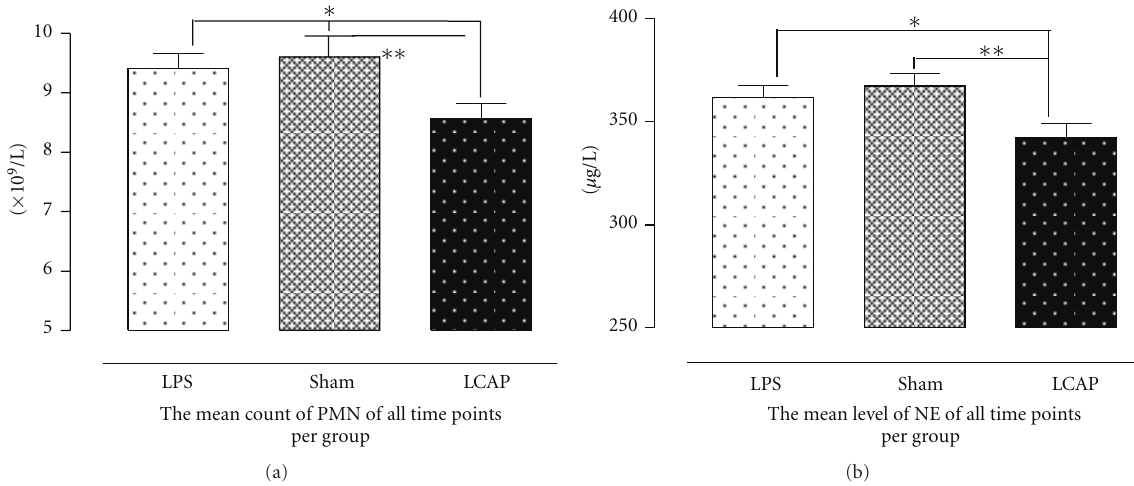
Figure 3: The e ff ect of LCAP on the average levels of PMN and NE in three groups. The numbers of PMN in the right femoral artery were counted at the indicated time period using the Digicell 500 cell counter (a), and the mean levels of NE in sera at the same time periods were determined by ELISA kits (R&D, USA) according to the manufacturer’s instructions (b). ∗ indicates significant di ff erence between the LCAP and the sham-LCAP groups ( P < 0 . 05). ∗∗ indicates significant di ff erence between the LCAP and the LPS groups ( P < 0 .